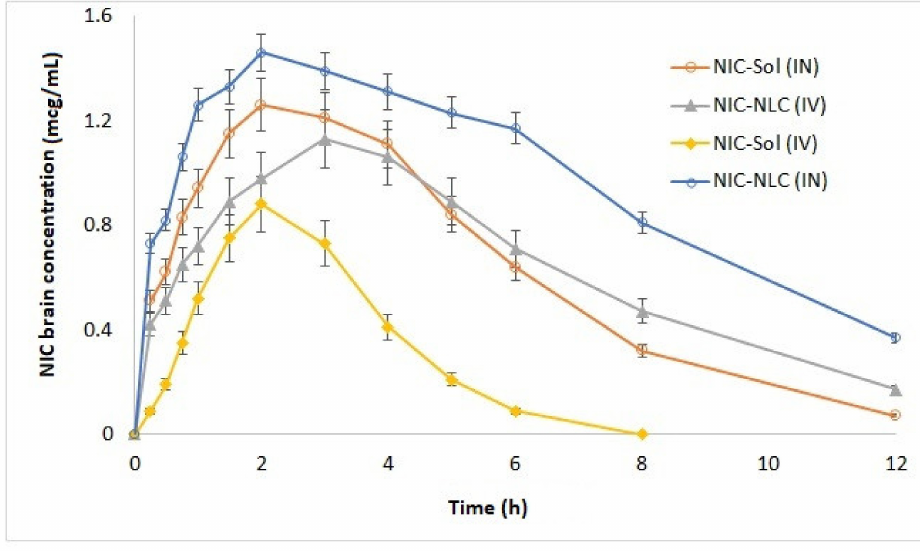
Figure 9. Mean brain homogenate concentration–time profiles of optimized NIC–NLC compared to NIC–SOL following IN and IV administrations to Wister